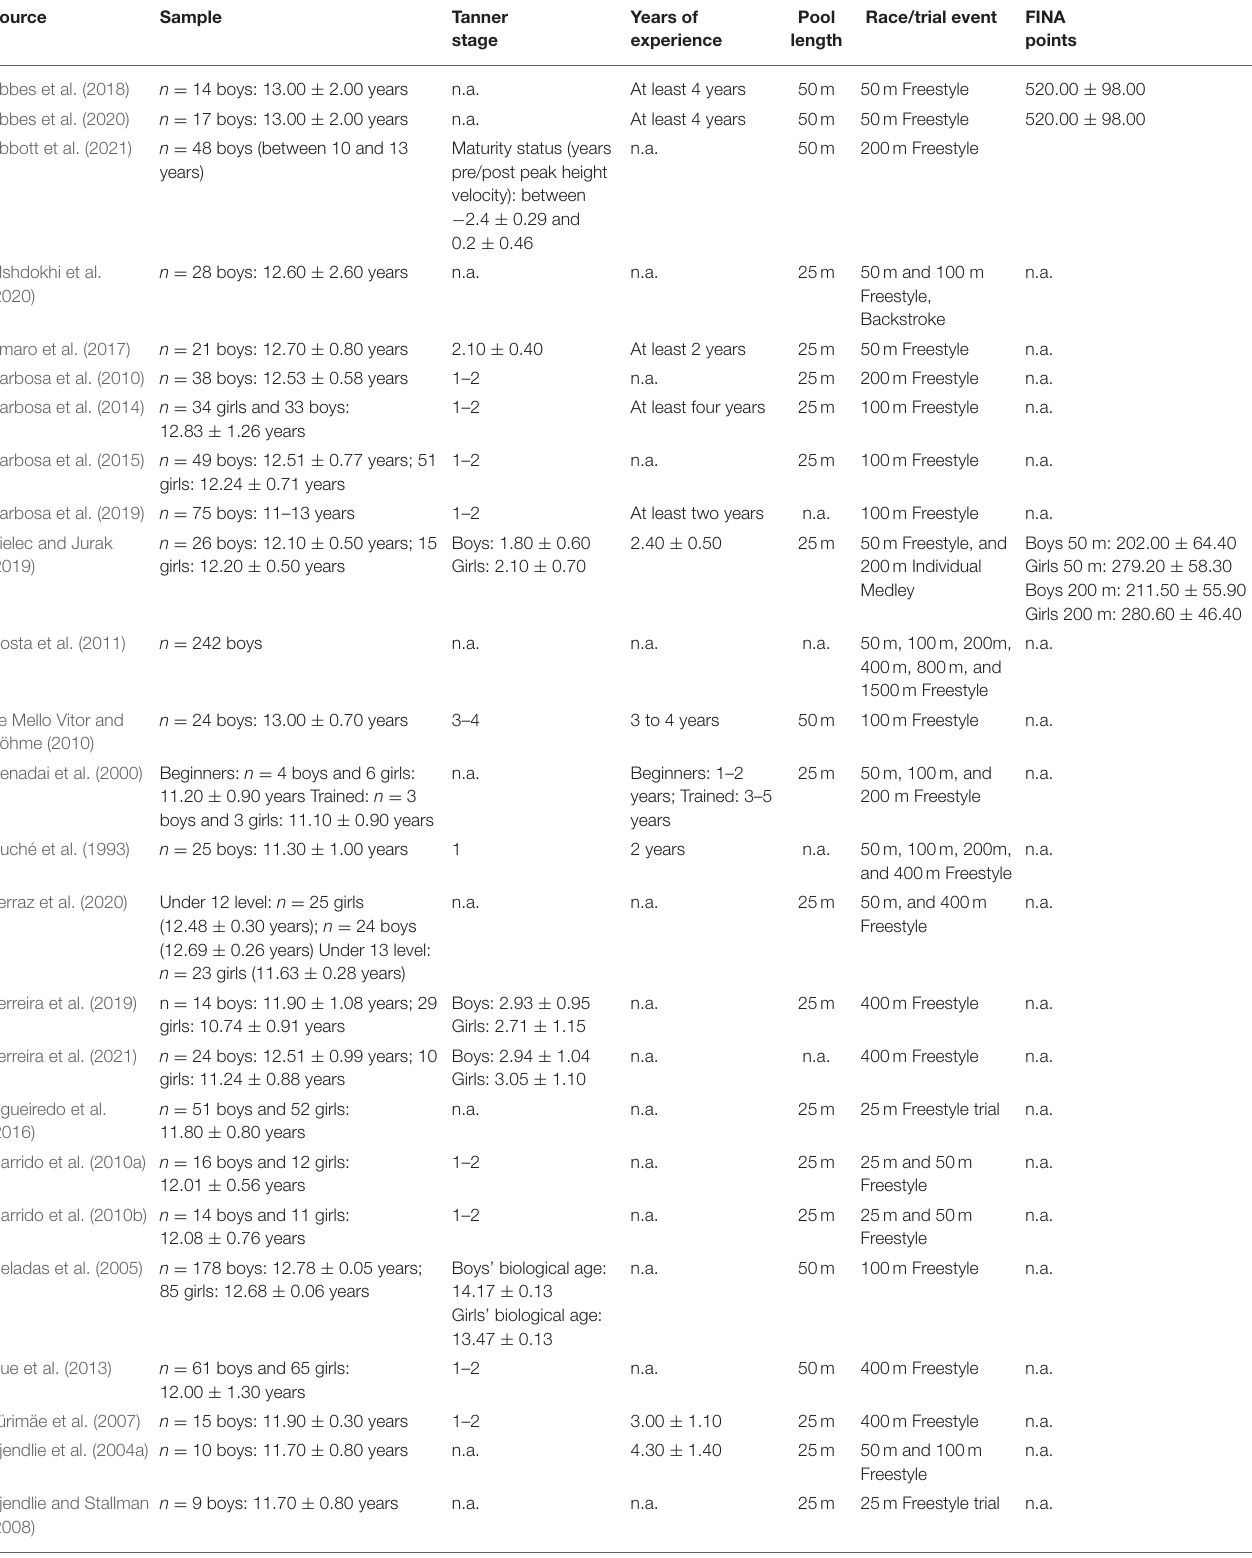
TABLE 2 | The summary of the sample demographics of each study included for analysis. Source Sample Tanner